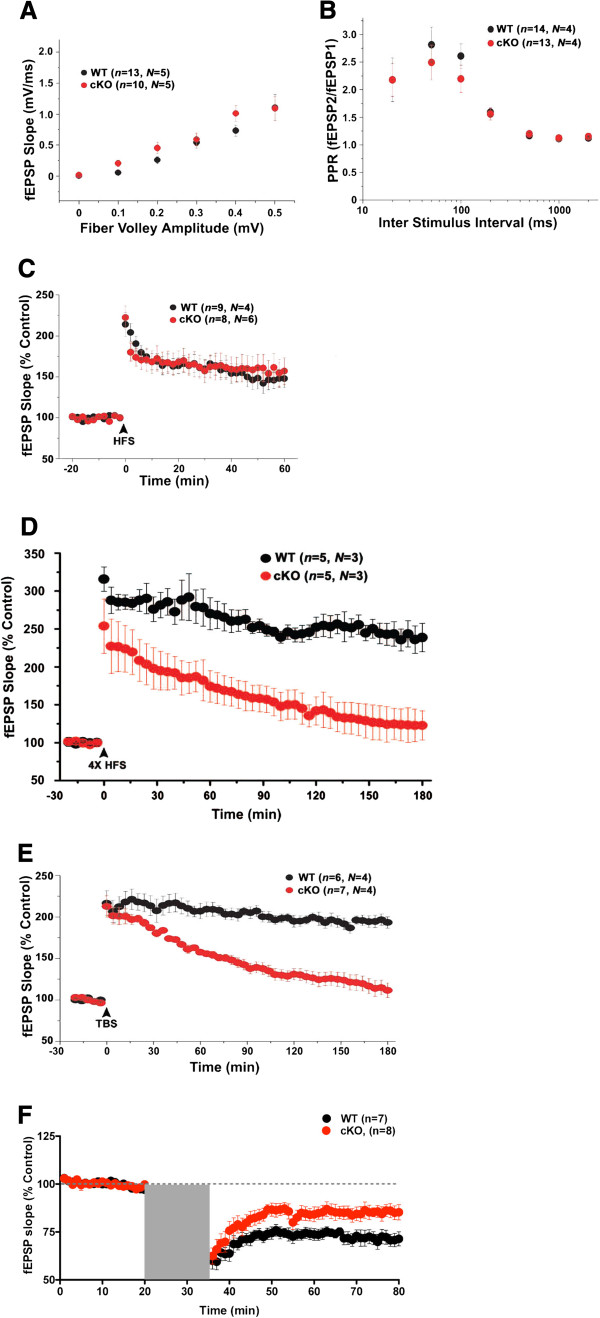
Impaired late-phase LTP and LTD in the mib1 cKO mice. (A) Normal synaptic transmission in mib1 cKO mice. The synaptic input–output relationship was obtained by plotting the fiber volley amplitude against the initial slope of the evoked fEPSP. (B) Normal paired-pulse response ratio in mib1 cKO mice. The graph depicts the paired-pulse response ratio (2nd fEPSP/1st fEPSP) obtained at different interstimulus intervals (in ms). (C) Normal E-LTP in mib1 cKO mice. Time course of the effects of 1 train of high-frequency stimulation (HFS) on the fEPSP initial slope. (D) Impaired L-LTP induced by four trains of tetanic stimulation in mib1 cKO mice. Time course of the effects of 4 X HFS stimulation on the fEPSP initial slope. (E) Impaired L-LTP in mib1 cKO mice. Time course of the effects of theta-burst stimulation (TBS) on the fEPSP initial slope. (F) Impaired LFS-LTD in mib1 cKO mice. Time course of the effects of LFS stimulation on the fEPSP initial slope. The gray area represents the duration of LFS (low-frequency stimulation, 900 pulses at 1 Hz) for 15 minutes. The number of slices (n) and mice (N) used in each experiment is indicated in parentheses. Error bars show the s.e.m.